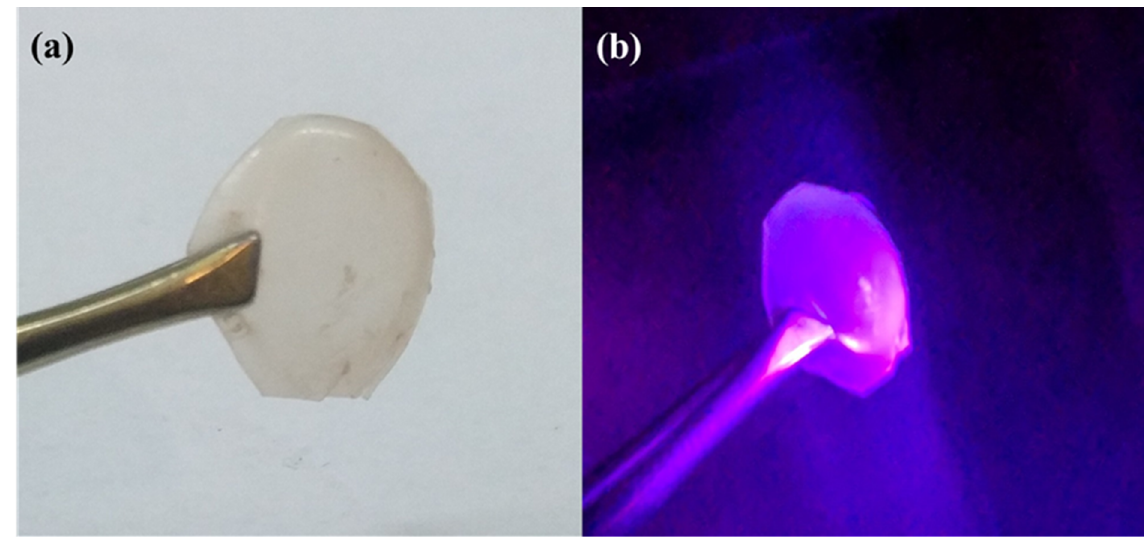
Figure 10. The red photoluminescent polymer nanocomposite containing polythiophene-derived dots under natural ( a ) and UV light ( b ).